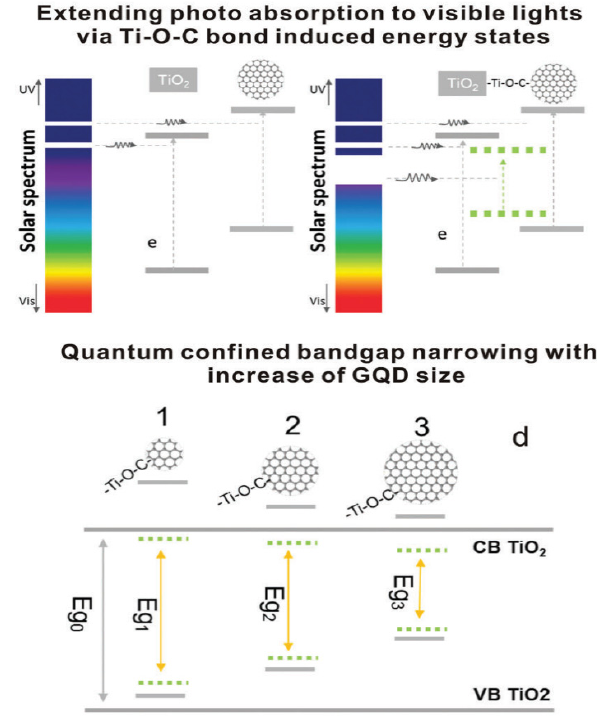
Figure 26. Schematic representation of enhanced visible light absorption of TiO 2 -GQD catalyst through Ti-O-C bond. Reprinted from [35] with permission from The Royal Society of Chemistry.